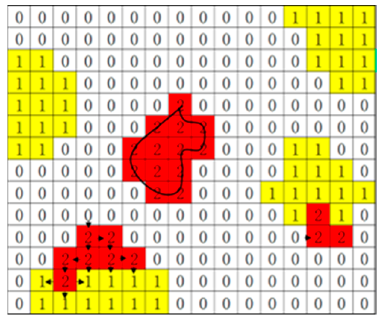
Figure 1. Candidate droplet identification mechanism.